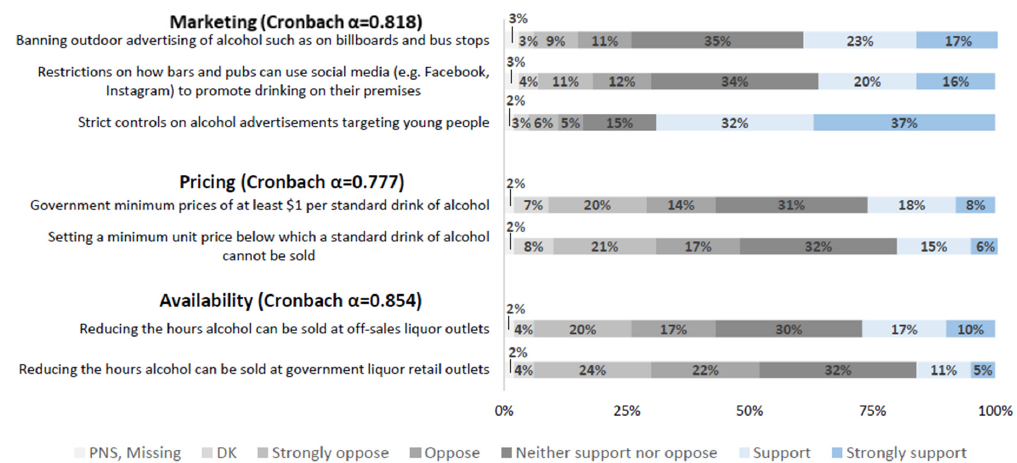
Figure 2. Level of support for alcohol policies from participants’ last survey wave completed. Percent missing varies from 1.16% to 1.56% for seven policy measures. Note: DK = Don’t know, PNS = Prefer not to say.